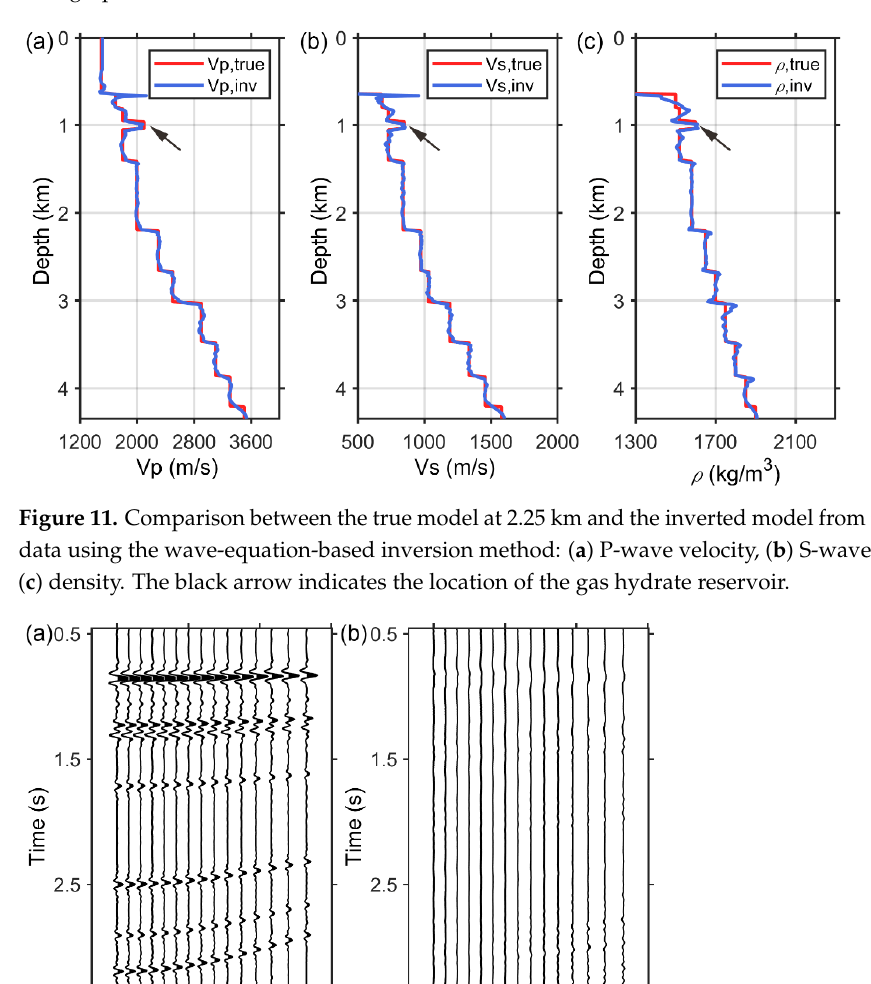
Figure 10. The inverted models from the noise-free data using the wave-equation-based inversion method: ( a ) P-wave velocity, ( b ) S-wave velocity, and ( c ) density. The black lines indicate the stratigraphic horizons and the red lines indicate the faults.